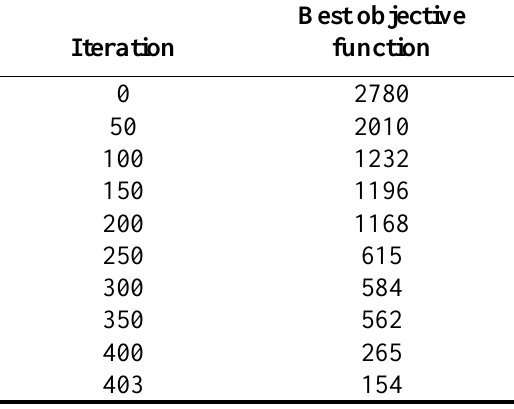
Table 4 – Development of objective function best